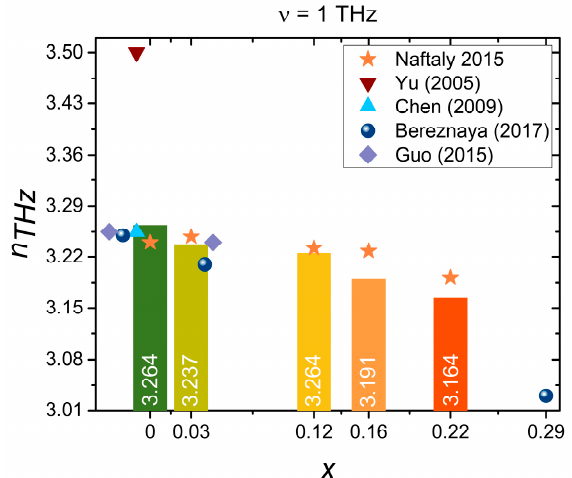
Figure 8. Ordinary refractive index of the GaSe:S crystals at a frequency of 1 THz. Data, measured in this work, are presented in bars and compared with the results published in other works: Guo (2015) [25], Bereznaya (2017) [38], Naftaly (2015) [53], Chen (2009) [54], Yu (2005) [63]. Some data for undoped GaSe is shifted horizontally for better readability.